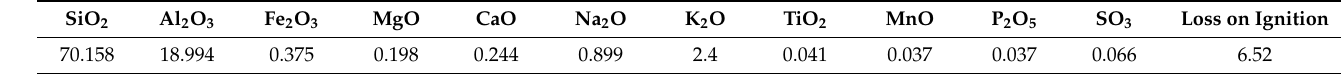
Figure 3. XRD pattern of the lab-used clay, I: illite, K: kaolinite, Q: quartz, Ab: albite, Pl: plagioclase. Table 2. Main chemical composition (by % weight) of the lab-used clay. Table 2. Main chemical composition (by % weight) of the lab-used clay.